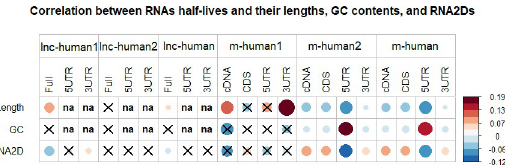
Fig 5. Spearman correlation between the half-lives of transcripts and their lengths, GC contents, or secondary structures (RNA2D) were displayed for lnc-human1, lnc-human2, lnc-human, m-human1, m-human2, and m- human, respectively. For lncRNA, the full, 5UTR, and 3UTR stand for full lengths, 5’ UTR and 3’ UTR local fragments. For mRNAs, the cDNA, CDS, 5UTR and 3UTR stands for cDNAs, CDSs, 5’ UTR fragments, and 3’ UTR fragments, in which the 5UTR and 3UTR represent the regions with the most significant P value. The signs “ × ” and “na” stand for no statistical significance at P = 0.01 and missing value, respectively, and the sizes of round dots stand for the correlation